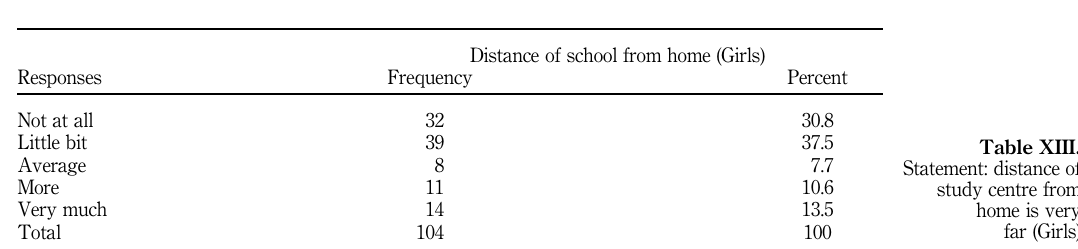
Table XII. statement: distance of study centers from home is very far